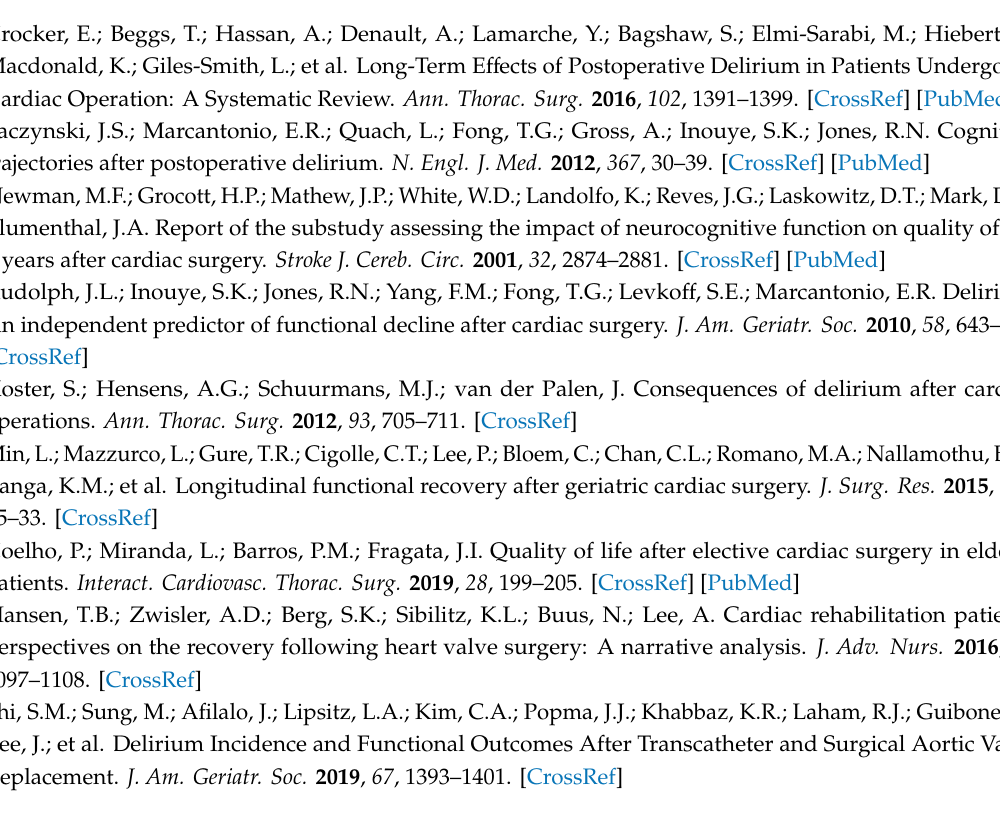
Table S1: Comparison of patients’ characteristics—follow-up vs. no